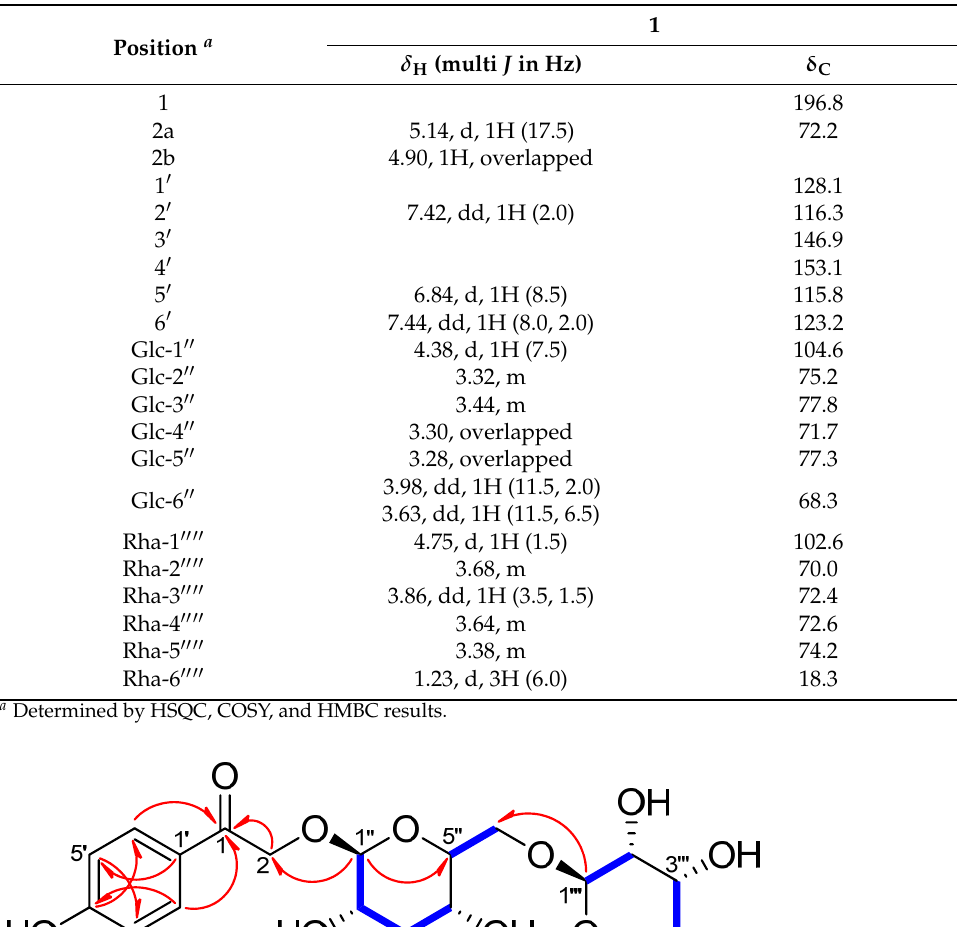
Table 2. 1 H and 13 C NMR spectroscopic data of compound 1 ( δ in ppm, methanol- d 4 , 500 and 125 MHz).